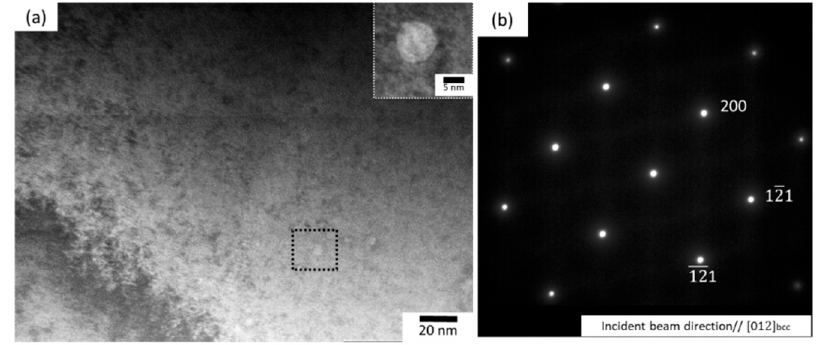
Figure 8. ( a ) TEM image (magnified image of the marked fine precipitate is shown in inset), and ( b ) selected area diffraction (SAD) image (at the matrix) of the TiNbZrHfTa alloy prepared at 1473 K for 3.6 ks.